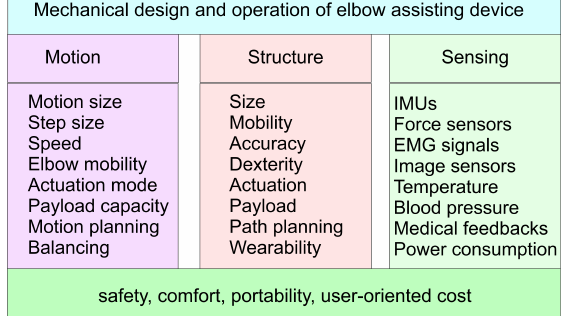
Figure 2. Requirements for improvements in CADEL.3